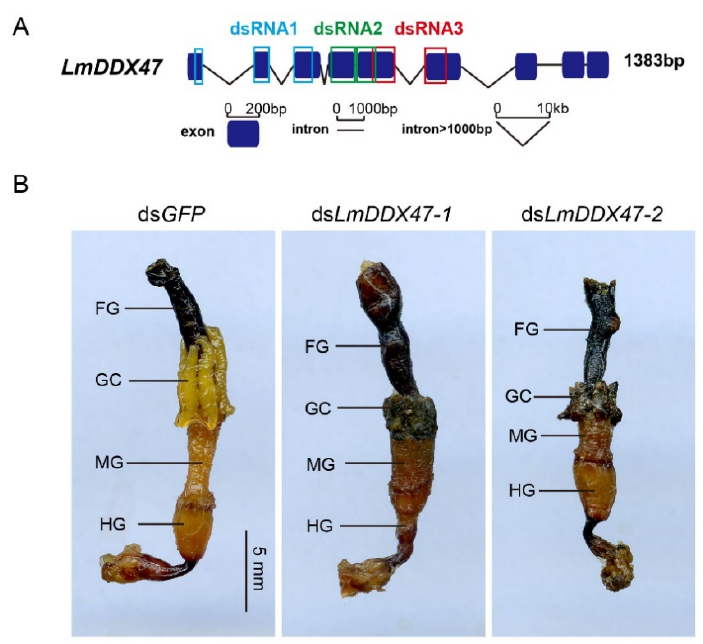
Figure 3. Three corresponding dsRNA regions and phenotypes of LmDDX47 knockdowns. ( A ) Tar- get regions of three dsRNAs in LmDDX47 are indicated in different colors. ( B ) Gut phenotypes after injecting ds LmDDX47 -1 and ds LmDDX47 -2. FG: foregut; GC: gastric cecum; MG: midgut; HG: hind- gut.